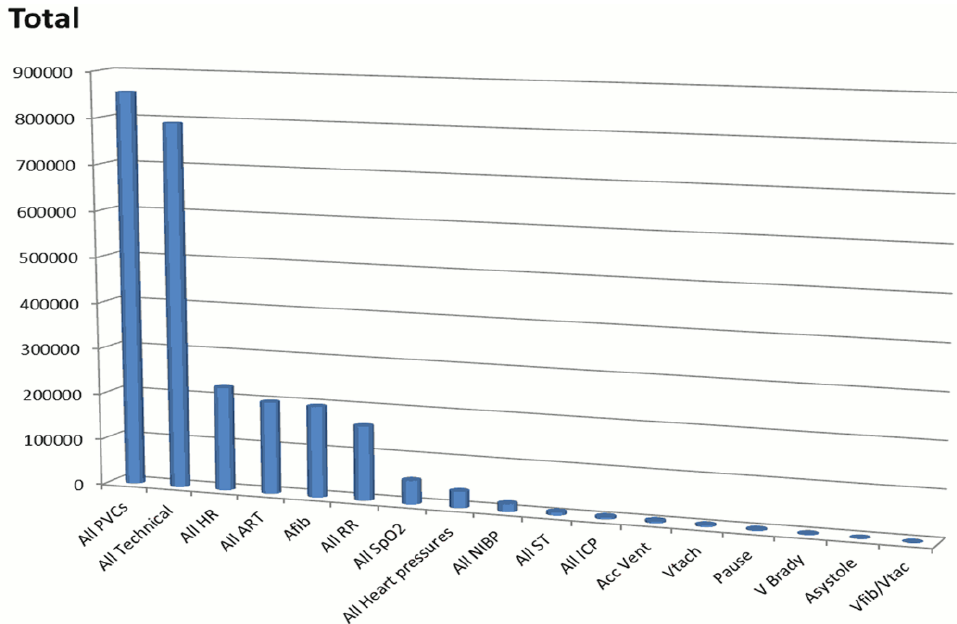
Figure 1. Frequency of all unique physiologic alarms from bedside ICU monitors over a 31-day study period. Figure from Drew, B.J. et al. [2] (open access with permission to use Figure). Abbreviations: ACC Vent = accelerated ventricular rhythm; Afib = atrial fibrillation; ART = arterial blood pressure; HR = heart rate; ICP = intracranial pressure; NIBP = non-invasive blood pressure; PVC = premature ventricular complexes; RR = respiratory rate; Sp02 = saturation of peripheral oxygen; ST = ST-segment; Vtach = ventricular tachycardia; V brady = ventricular bradycardia; and Vfib = ventricular fibrillation. Table 1. Accuracy of 12,671 audible arrhythmia alarms.